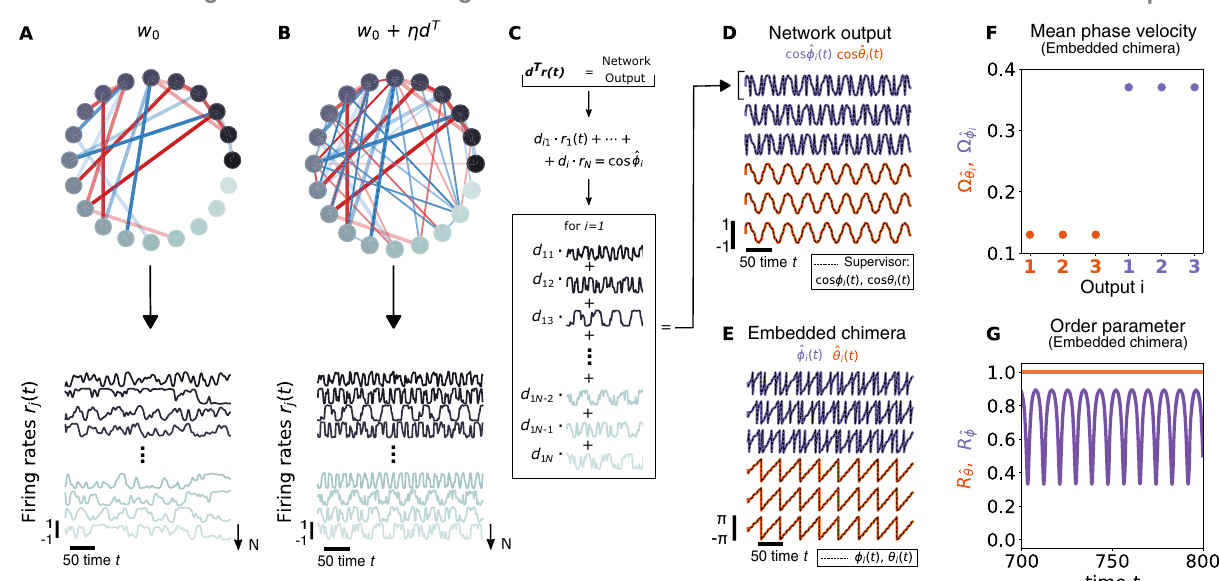
Fig. 2 Embedded Chimera state from network output using the FORCE method. A In the FORCE method an initial sparse matrix ω 0 initializes the neurons to chaotic fi ring rates. B A secondary set of weights η d ⊤ is learned online with the Recursive Least Squares technique. These learned weights are added to the initial sparse matrix, leading to the fi ring rates r(t) which are used to compute the network output. For both matrices in panels A and B blue and red edges (dark and light gray for b/w printing) indicate respectively excitatory (positive) or inhibitory (negative) connections. Edge thickness represents the weight of each connection. C The network output is given by d ⊤ r(t) , which is a s x n t matrix ( s is the total number of supervisors). Each network output column i is n t time units long and is a linear combination of the fi ring rates r 1 ( t ), ⋯ , r N ( t ) with d iN as coef fi cients. D Network output cos ^ ϕ ð t Þ (purple or dark gray for b/w printing) and cos ^ θ ð t Þ (orange or light gray for b/w printing) and the correspondent supervisors (black). E Embedded chimera from network . F Mean phase velocity pro fi le for the embedded chimera (identical pro fi les as in Fig. 1F). G Trajectories of the order parameter for the embedded chimera (identical trajectories as in Fig.